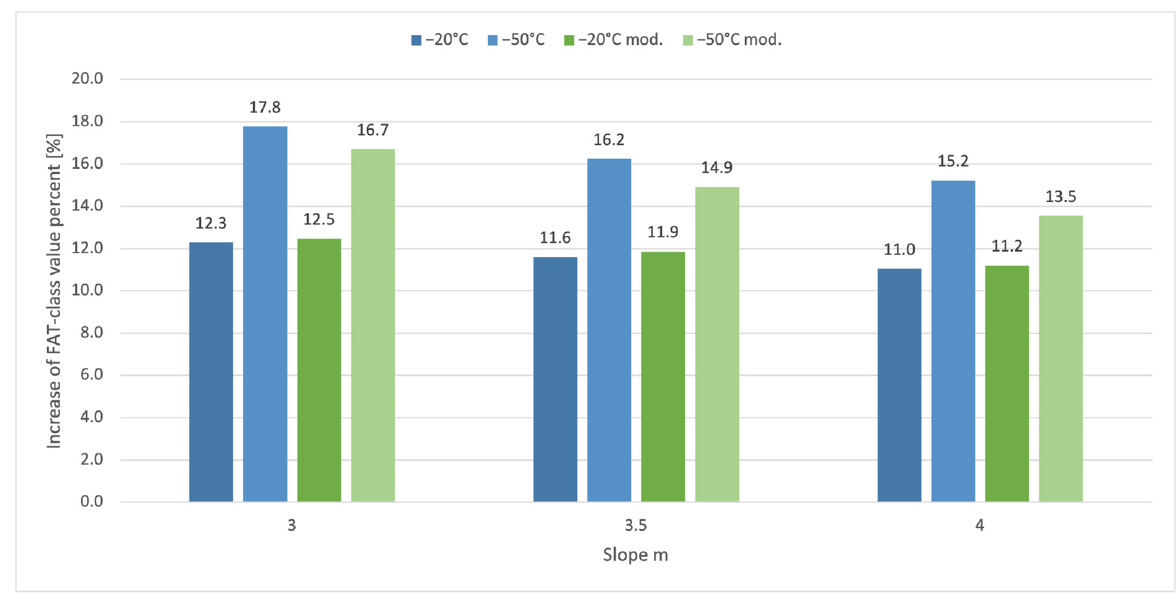
Figure 10. Increase in the FAT-class value in percent of tested AH36 cut edges at sub-zero temperatures compared to RT and of modified test series compared to RT modified. In the modified test series, the nominal stresses in the cross sections at the actual crack locations are used instead of the nominal stresses at the smallest cross sections.